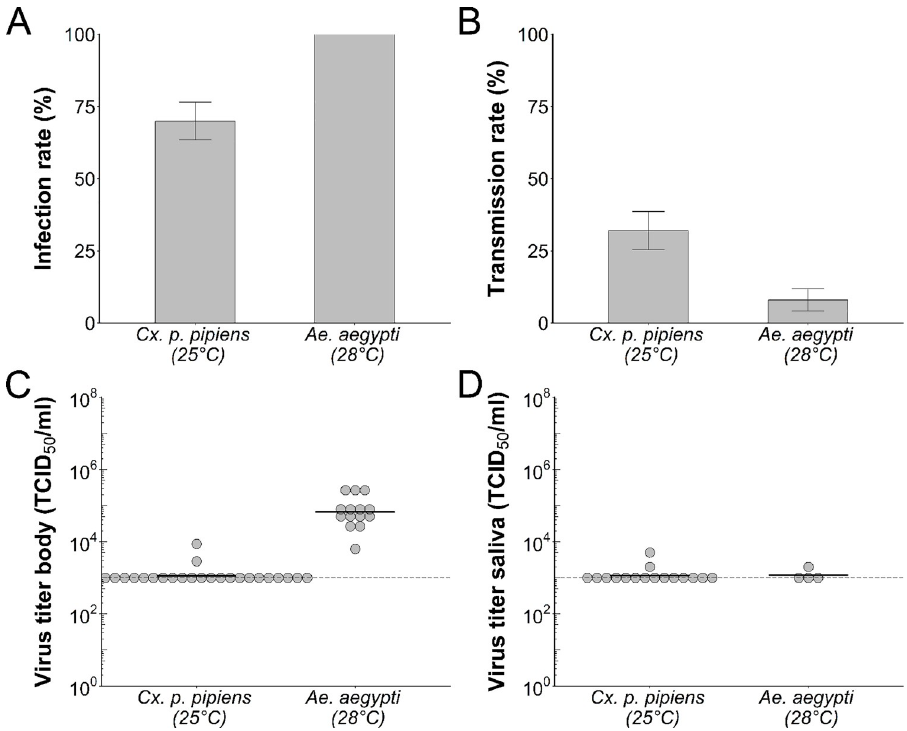
Fig 3. Infection rates, transmission rates, and virus titers of mosquitoes intrathoracically injected with Shuni virus (SHUV). Mean infection rates (A) and transmission rates (B) of Culex pipiens pipiens (N = 50) and Aedes aegypti (N = 50) intrathoracically injected with SHUV after 10 days incubation at 25˚C and 28˚C, respectively. Infection rates are presented as the percentage of virus-positive body or saliva samples, respectively, out of the total number of injected mosquitoes that remained alive at the end of the incubation period. Error bars indicate the SEM. SHUV titers of virus-positive body samples (C) and saliva samples (D) of Cx . p . pipiens (body samples: N = 26, saliva samples: N = 16) and Ae . aegypti (body samples: N = 14, saliva samples: N = 4) intrathoracically injected with SHUV after 10 days incubation at 25˚C and 28˚C, respectively. Each dot represents an individual sample, and the black bar indicates the mean. The detection limit of the endpoint dilution assay is indicated with the dashed